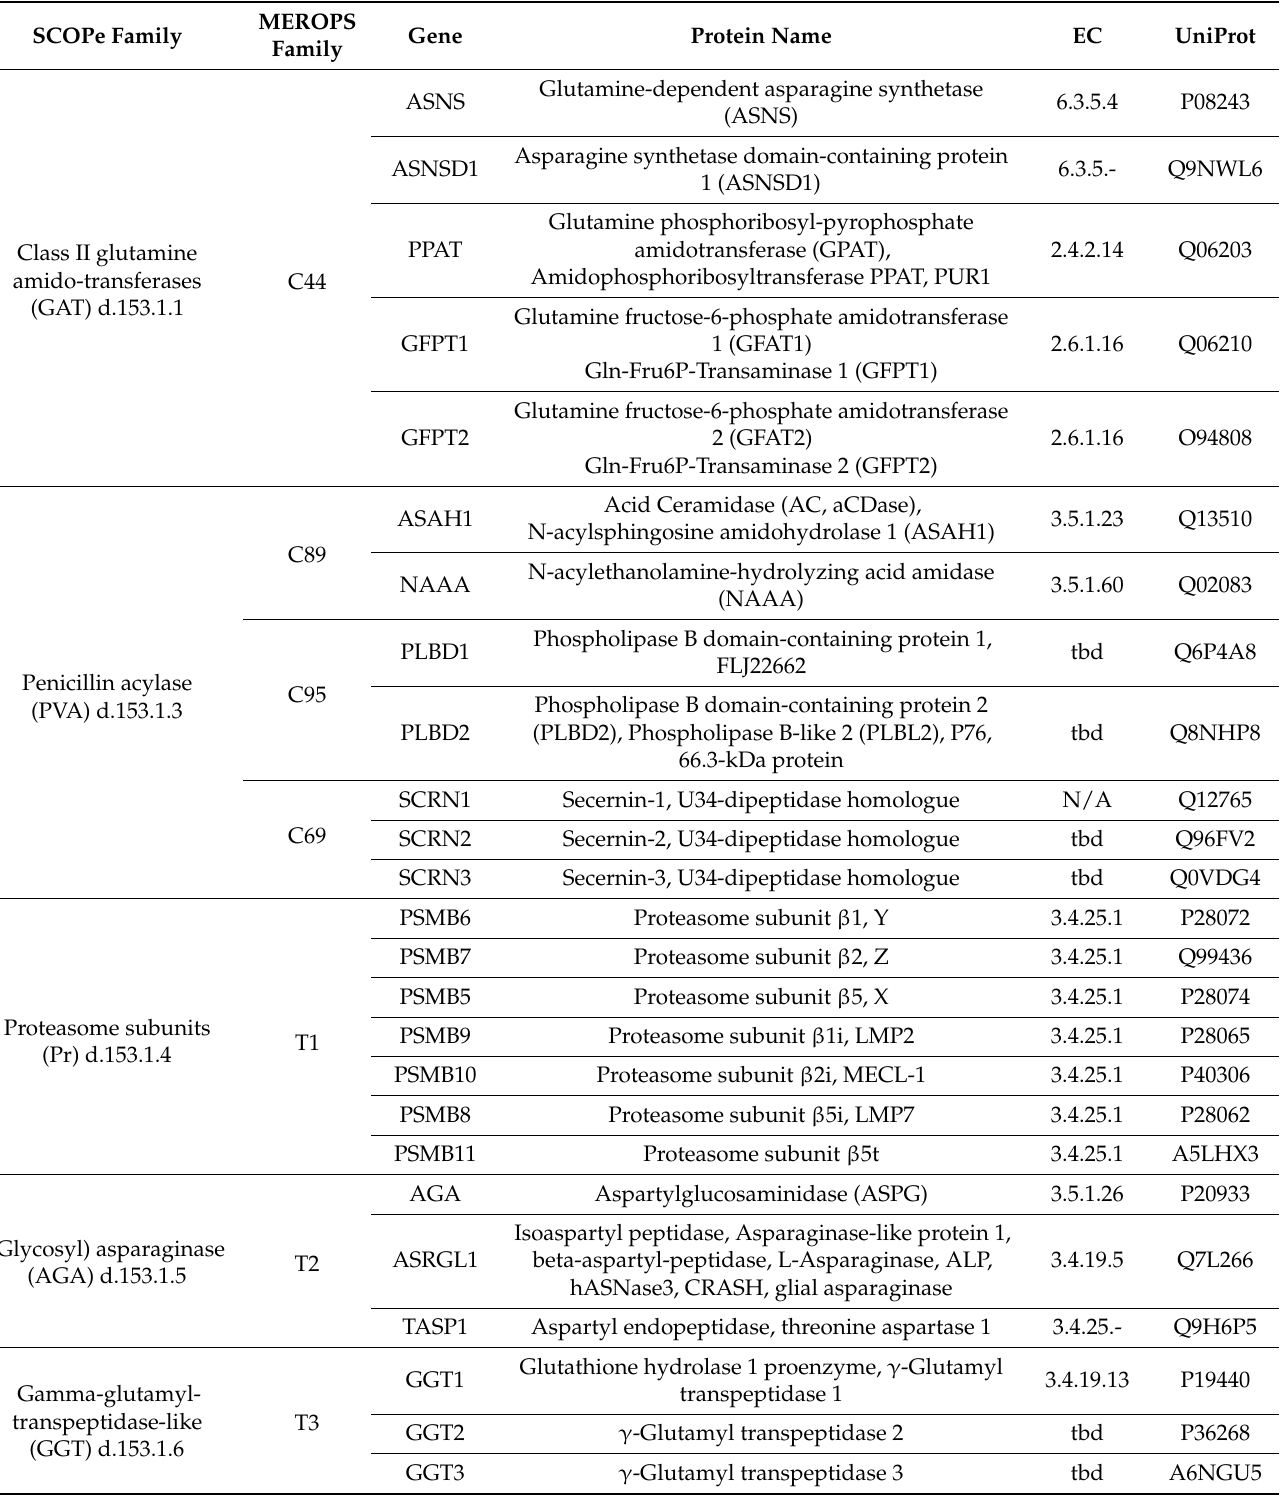
Table 2. Human Ntn-hydrolases. Members of the human Ntn-hydrolase superfamily with Uniprot identifier and EC-number (if applicable), assigned to subfamilies according to MEROPS and SCOPe classifications. The known inactive proteasome subunits α 1- α 7, α 4s, β 3- β 4, and β 6- β 7 are not listed. N/A = not applicable, tbd = to be determined; recommended protein names are stated